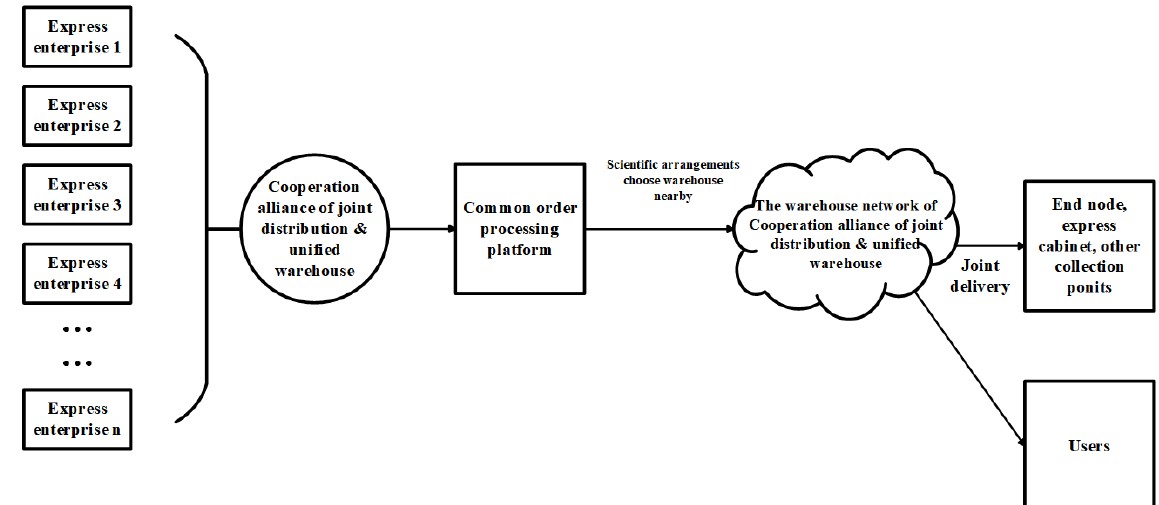
Figure 2. The flowchart of the model of a unified warehouse and